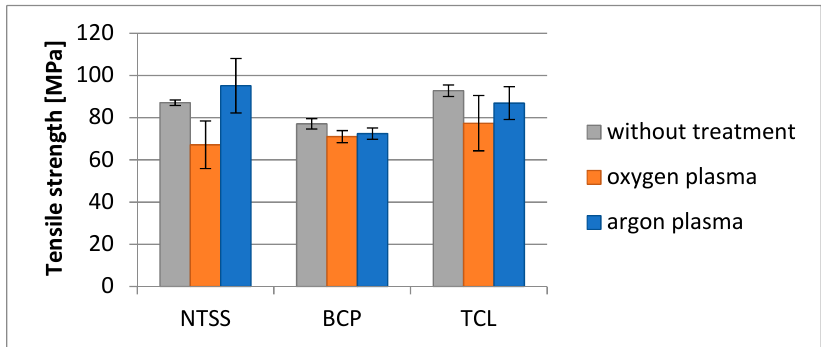
Figure 6. Changes in tensile strength in MD of the film due to plasma activation.